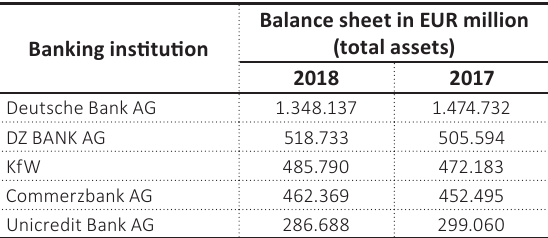
Table 2. German top 5 banks: balance sheet total 2018 in EUR million